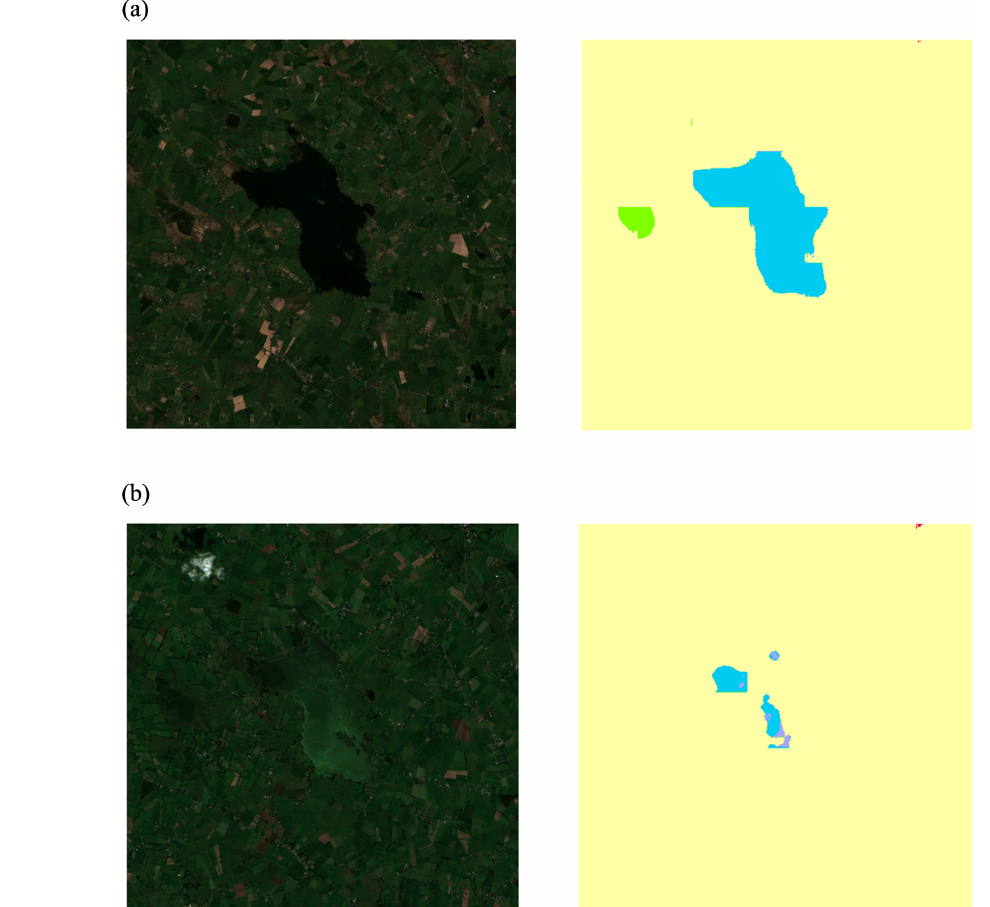
Figure 8. Lough Funshinagh, a Turlough (seasonal lake) in the West of Ireland (53.51, − 8 . 1) in (a) April 2020 and (b) August 2020, obtained from Sentinel-2 satellite images, with the corresponding UW map for both. The satellite images were produced from ESA remote sensing data.